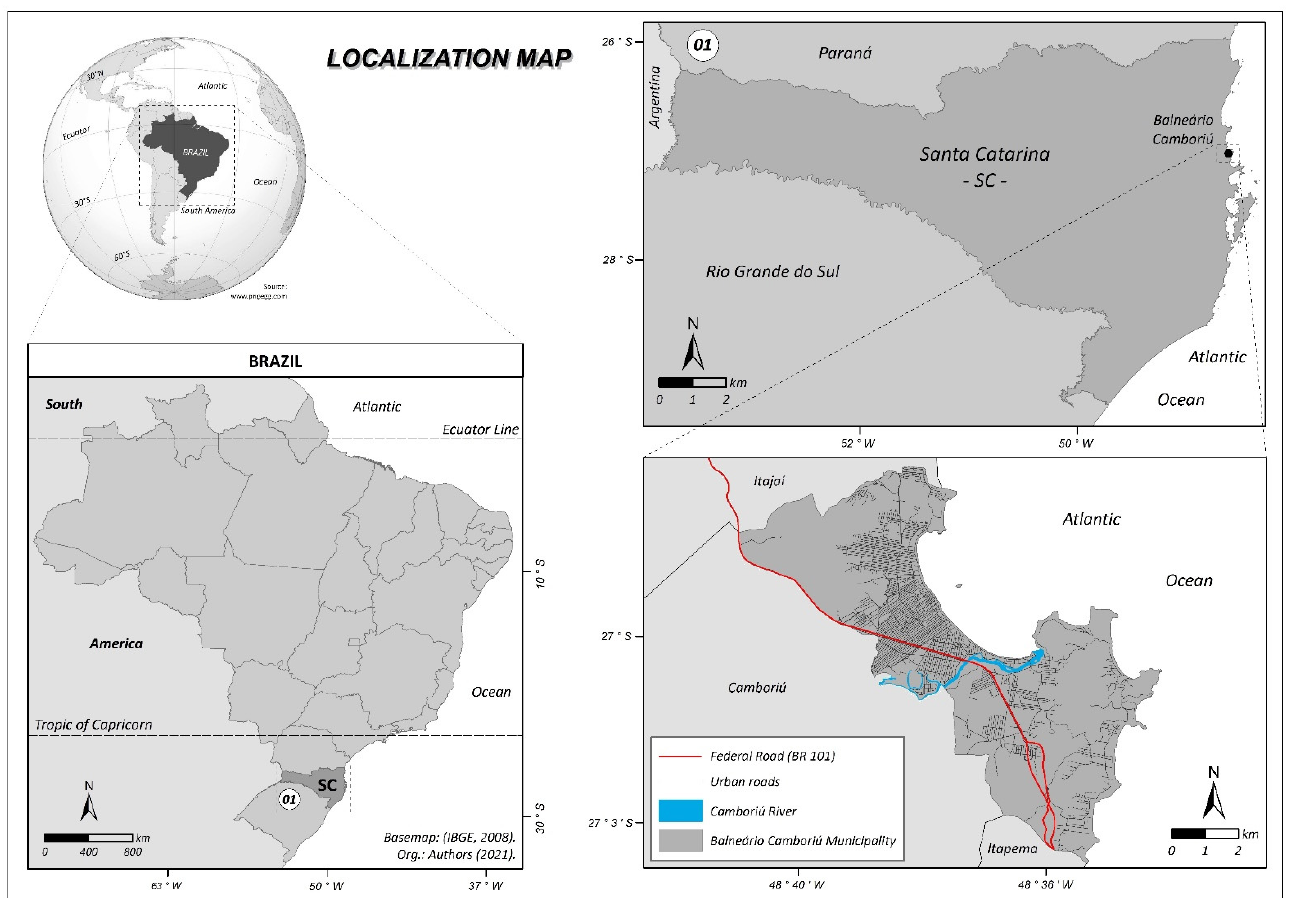
Figure 1. Localization map of Balneário Camboriú/SC, Brazil.